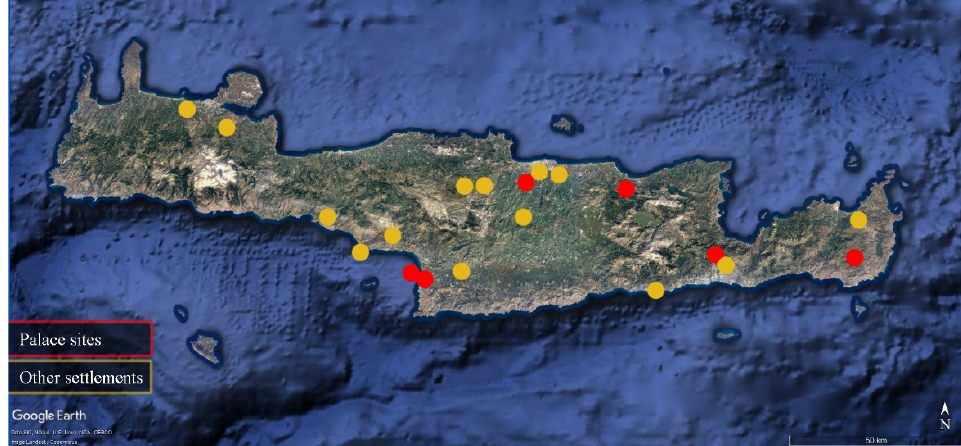
Figure 16. Central Minoan Crete settlements [198].